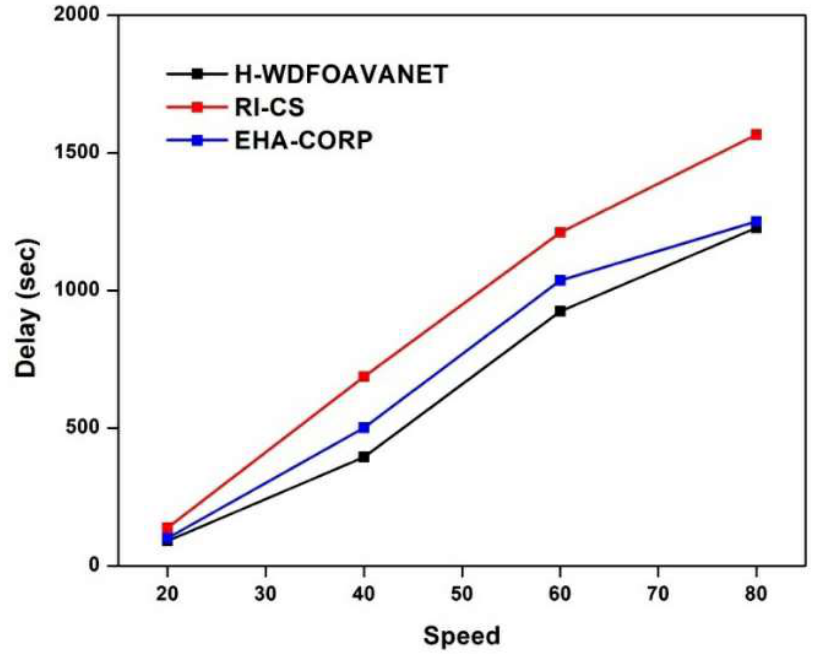
Figure 20. Plots of speed vs. delay in the suggested approach and existing approaches.